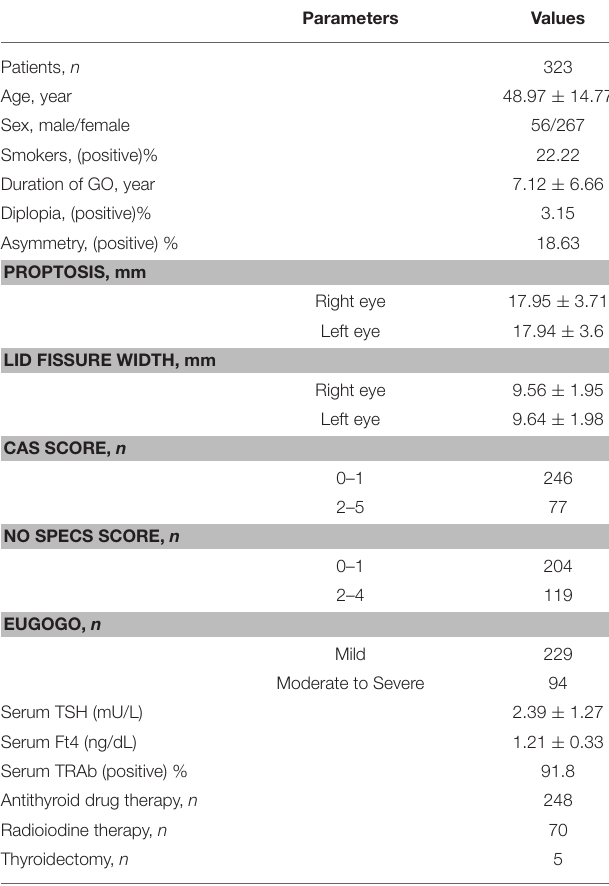
TABLE 1 | Baseline characterisitcs of the study GO